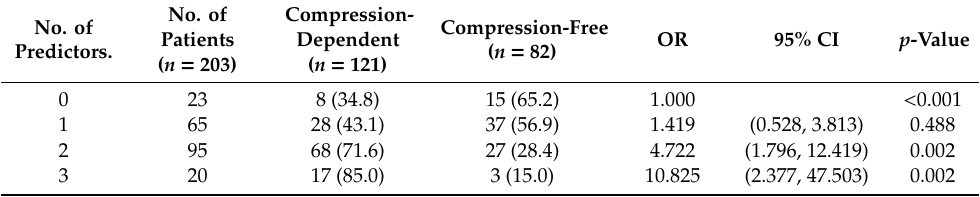
Table 5. Incidence and risk of the compression-dependent group according to the number of predictors. No. of